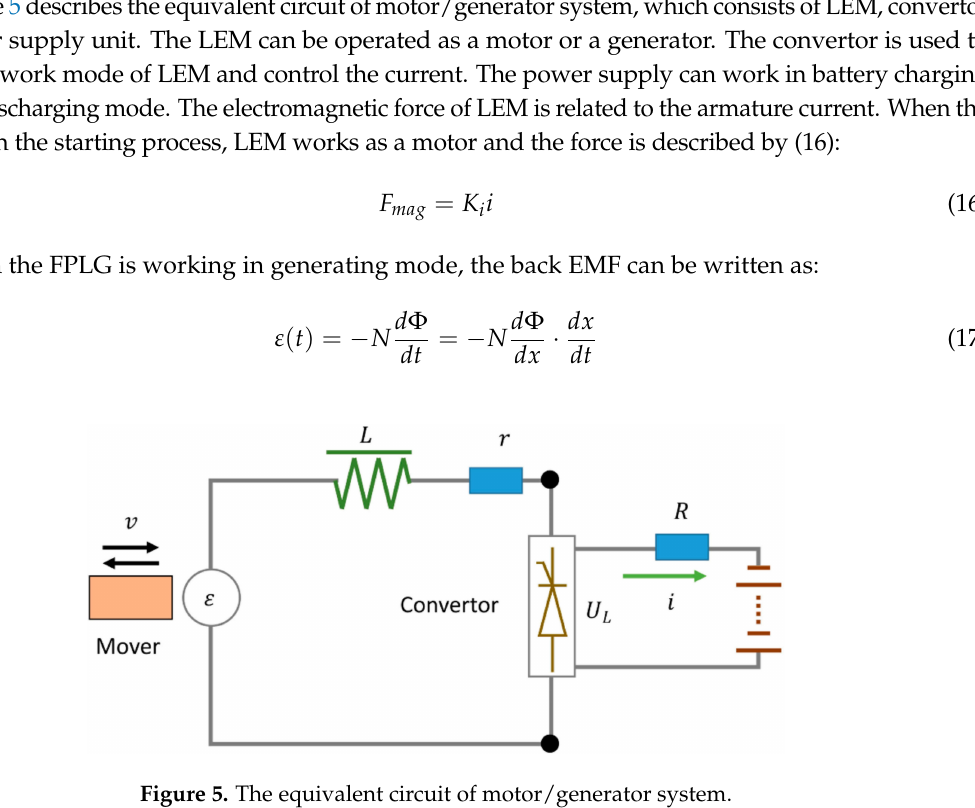
Figure 5. The equivalent circuit of motor/generator